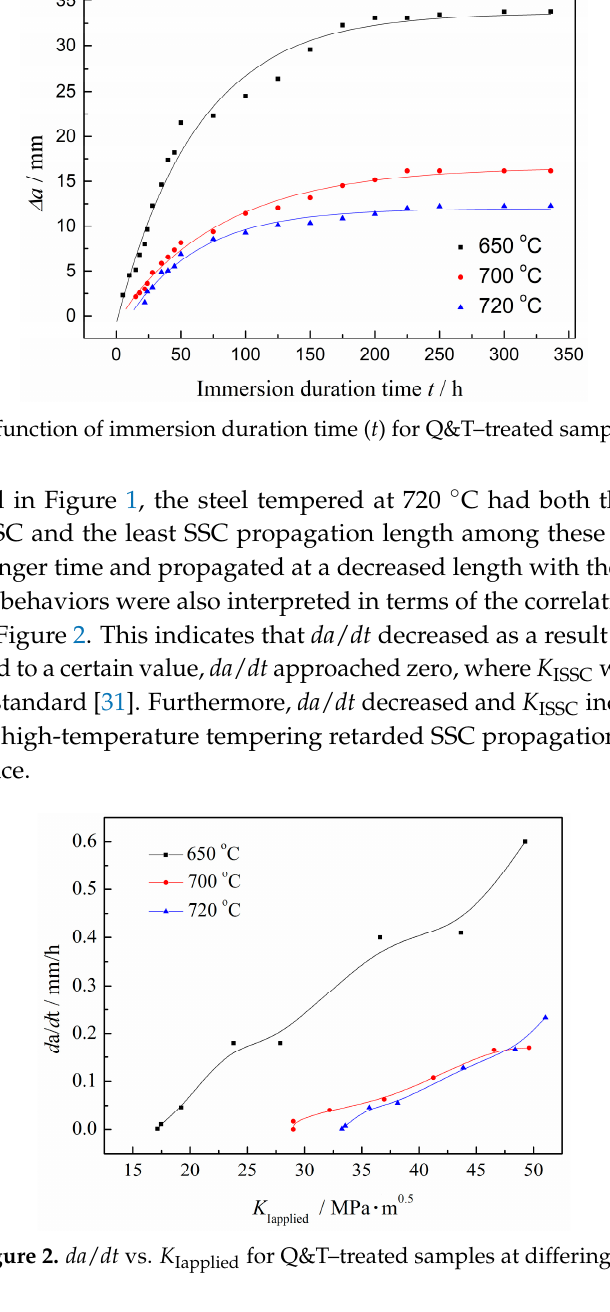
Figure 2. da/dt vs. K Iapplied for Q&T–treated samples at differing T t .